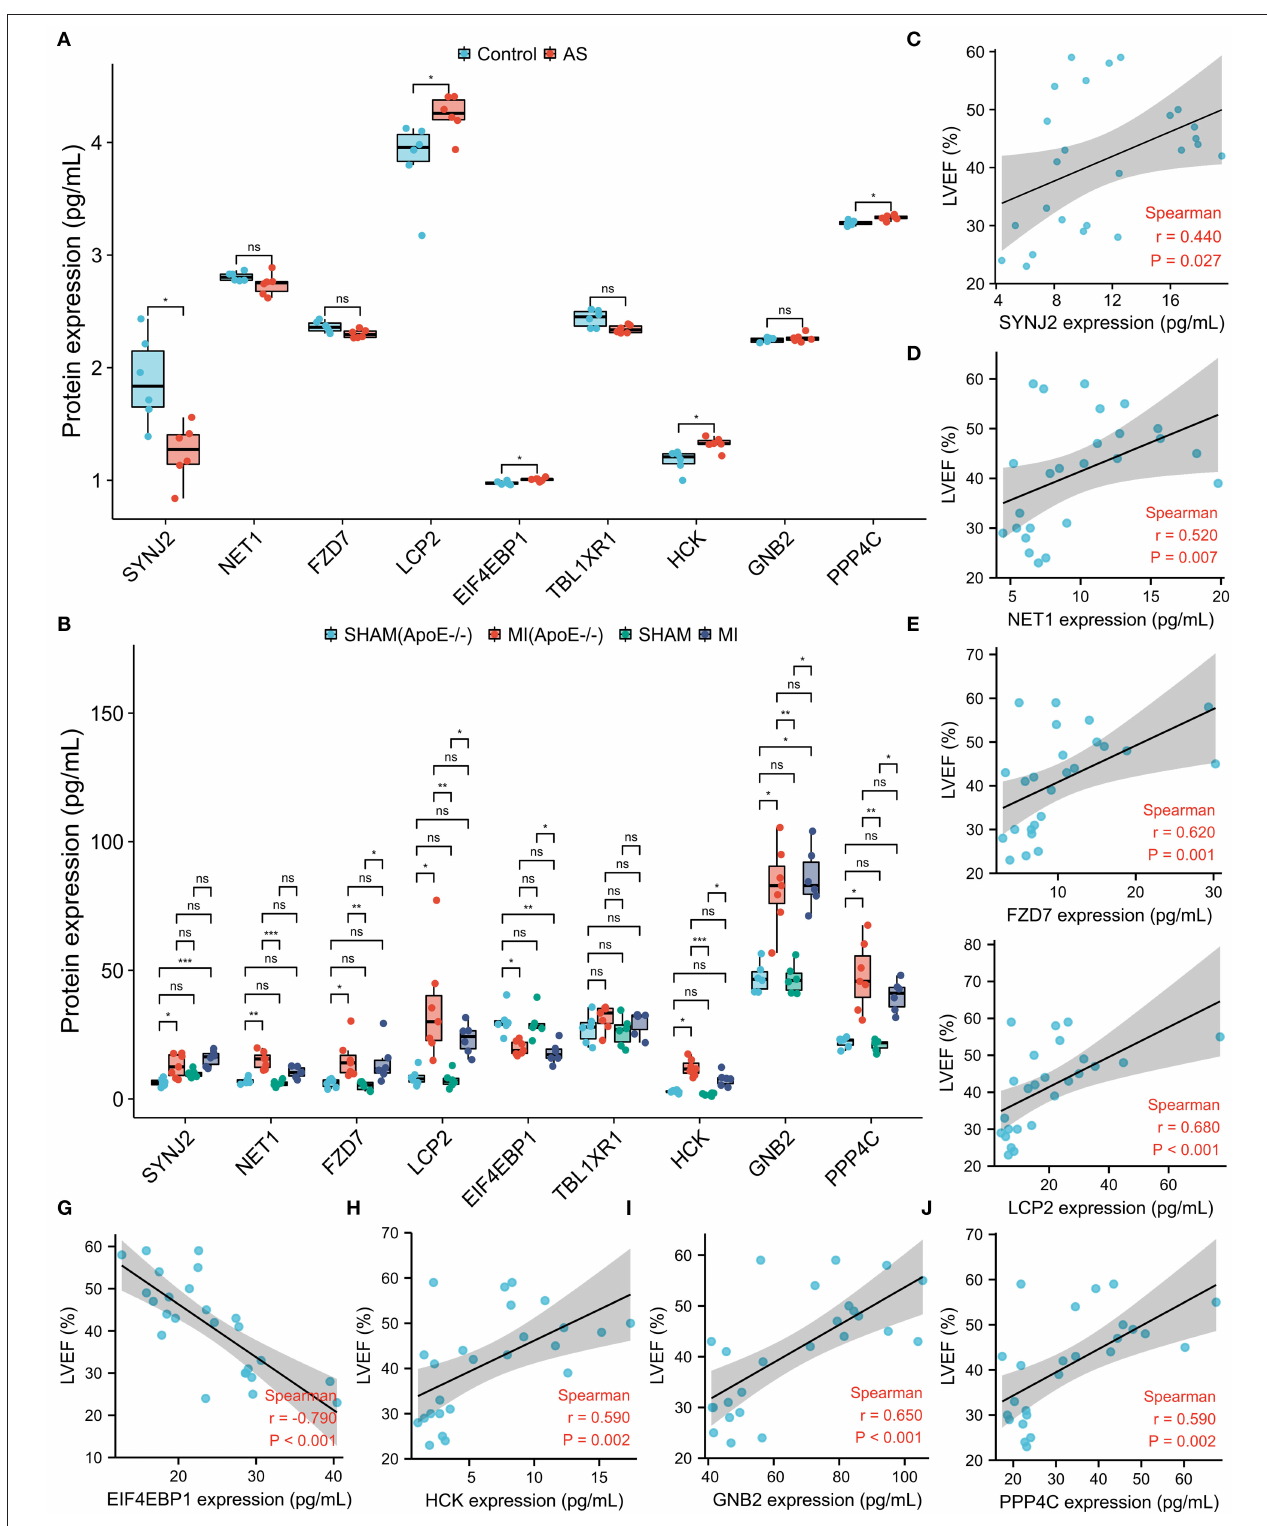
FIGURE 7 | The protein expression level of the nine screened hub differentially expressed macrophages-related genes (DEMRGs) in atherosclerosis and myocardial infarction (MI) mice model. (A) The expression level of the nine hub DEMRGs in atherosclerosis. (B) The expression level of the nine hub DEMRGs in MI and SHAM groups in ApoE-/- and C57Bl/6J mice. (C–J) The correlation between left ventricular ejection fraction (LVEF) and the nine DEMRGs expression level in the MI mice model, including SYNJ2 (C) , NET1 (D) , FZD7 (E) , LCP2 (F) , EIF4EBP1 (G) , HCK (H) , GNB2 (I) , and PPP4C (J) . * p < 0.05; ** p < 0.01; *** p < 0.001; ns, not significant.